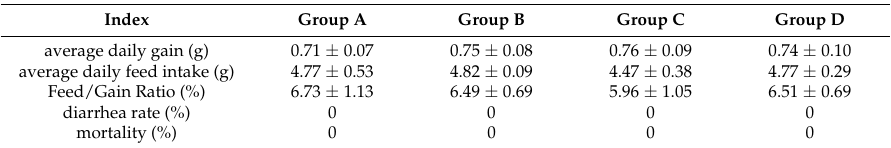
Table 1. Effect of intragastric administration with C. butyricum Sx-01, L. salivarius C-1-3 and a combination thereof on growth performance of